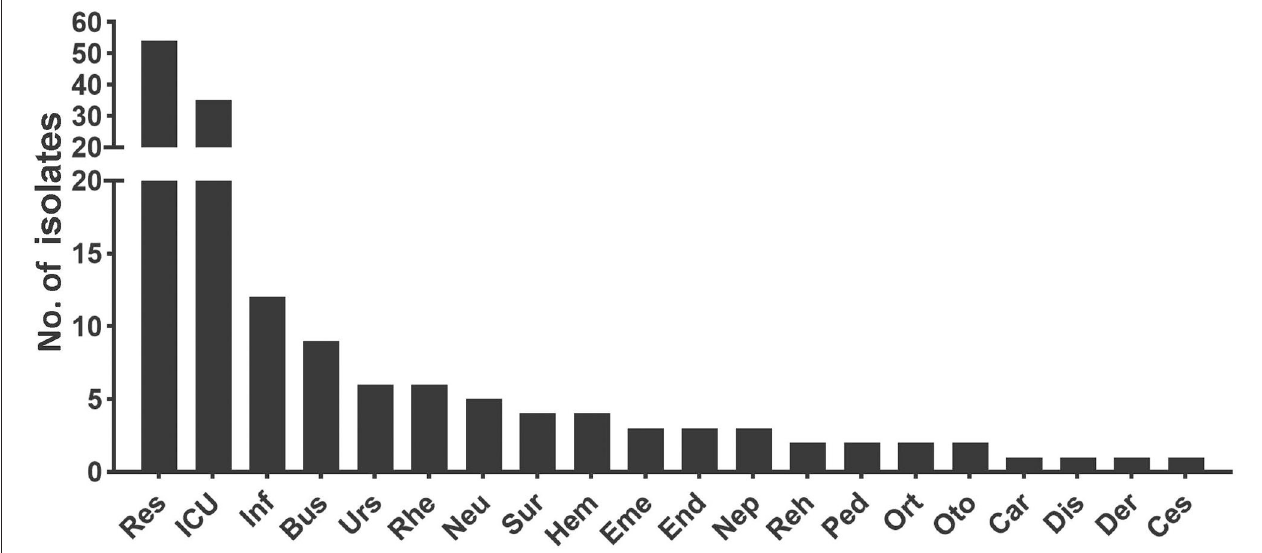
FIGURE 3 | The department distribution of patients infected with invasive Aspergillus isolates. Res, Department of Respiratory Medicine; ICU, Intensive Care Unit; Inf, Infection Unit; Bus, Burns Unit; Urs, Department of Urology; Rhe, Department of Rheumatology and Immunology; Neu, Department of Neurology; Sur, Department of Surgery including organ transplantation, hepatobiliary and pancreatic surgery, gastrointestinal surgery, and joint surgery; Hem, Department of Hematology; Eme, Emergency Room; End, Department of Endocrinology; Nep, Department of Nephrology; Reh, Department of Rehabilitation; Ped, Department of Pediatrics; Ort, Department of Orthopedics; Oto, Department of Otolaryngology; Car, Department of Cardiology; Dis, Department of Gastroenterology; Der, Department of Dermatological Venereology; Ces, Department of Chest Surgery.